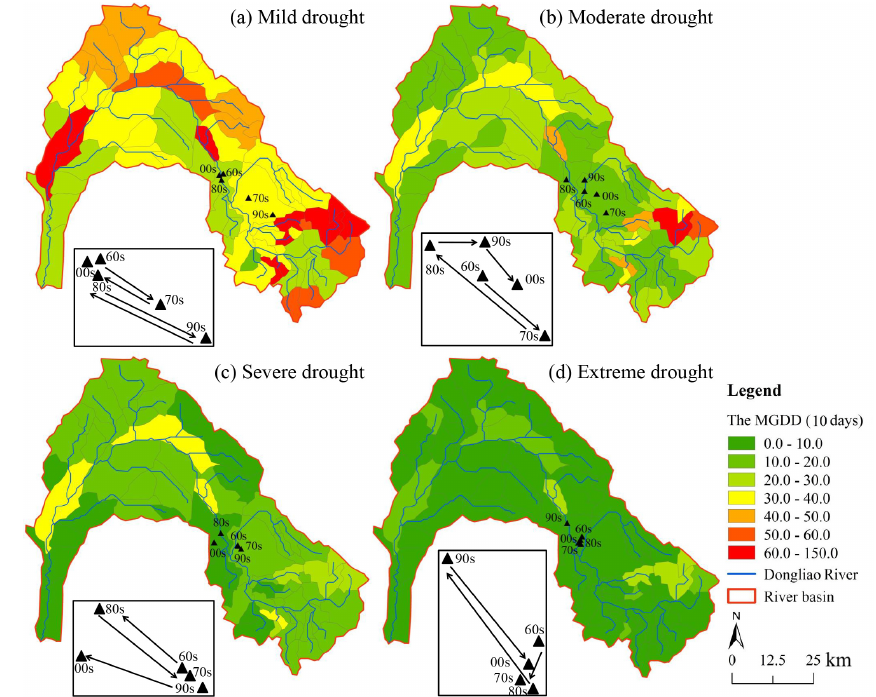
Figure 5. Spatial distribution of the MGDD of different drought levels in various